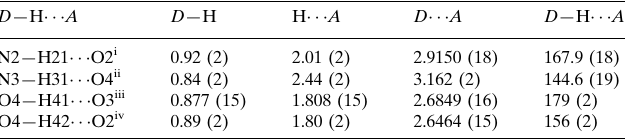
Hydrogen-bond geometry (A˚ , (cid:1)